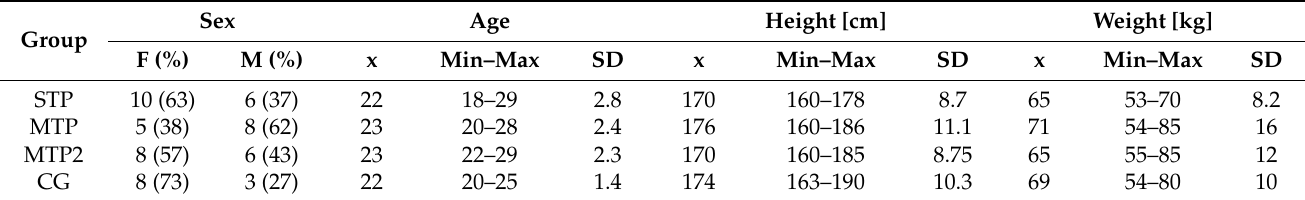
Table 1. Basic anthropometric data of the participants from particular